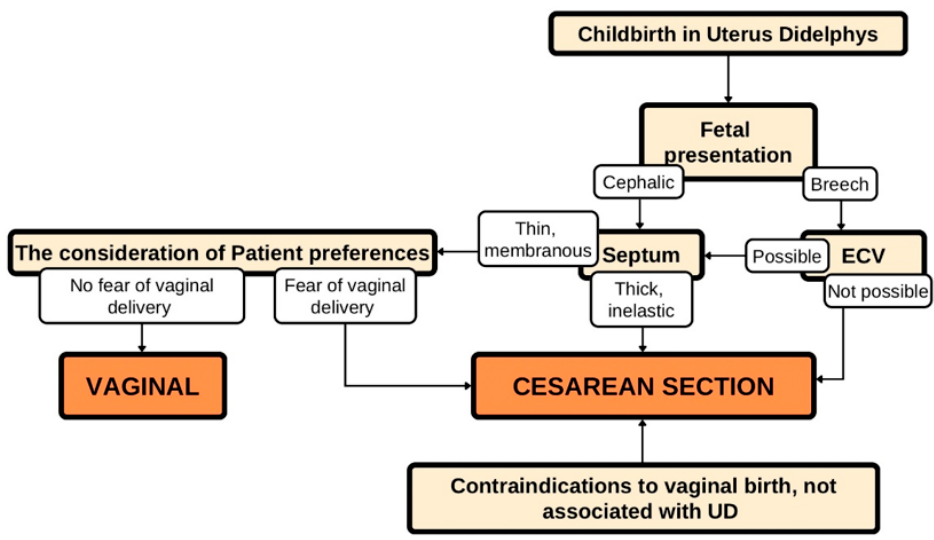
Figure 2. Termination of pregnancy in uterus didelphys depending on various factors.